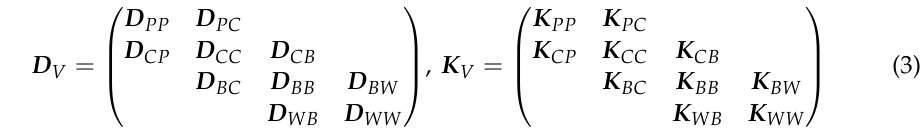
The subscripts P , C , B, and W in Equation (2) represent the pantograph, the car body, the bogie frame, and the wheelset, respectively. Some parameters are shown in Table 1. In terms of the wheel–rail contact part, the Hertzian contact algorithm is used to calculate the wheel–rail interaction point and force [27]. The polygonal contact model (PCM) is used to calculate the PC interaction